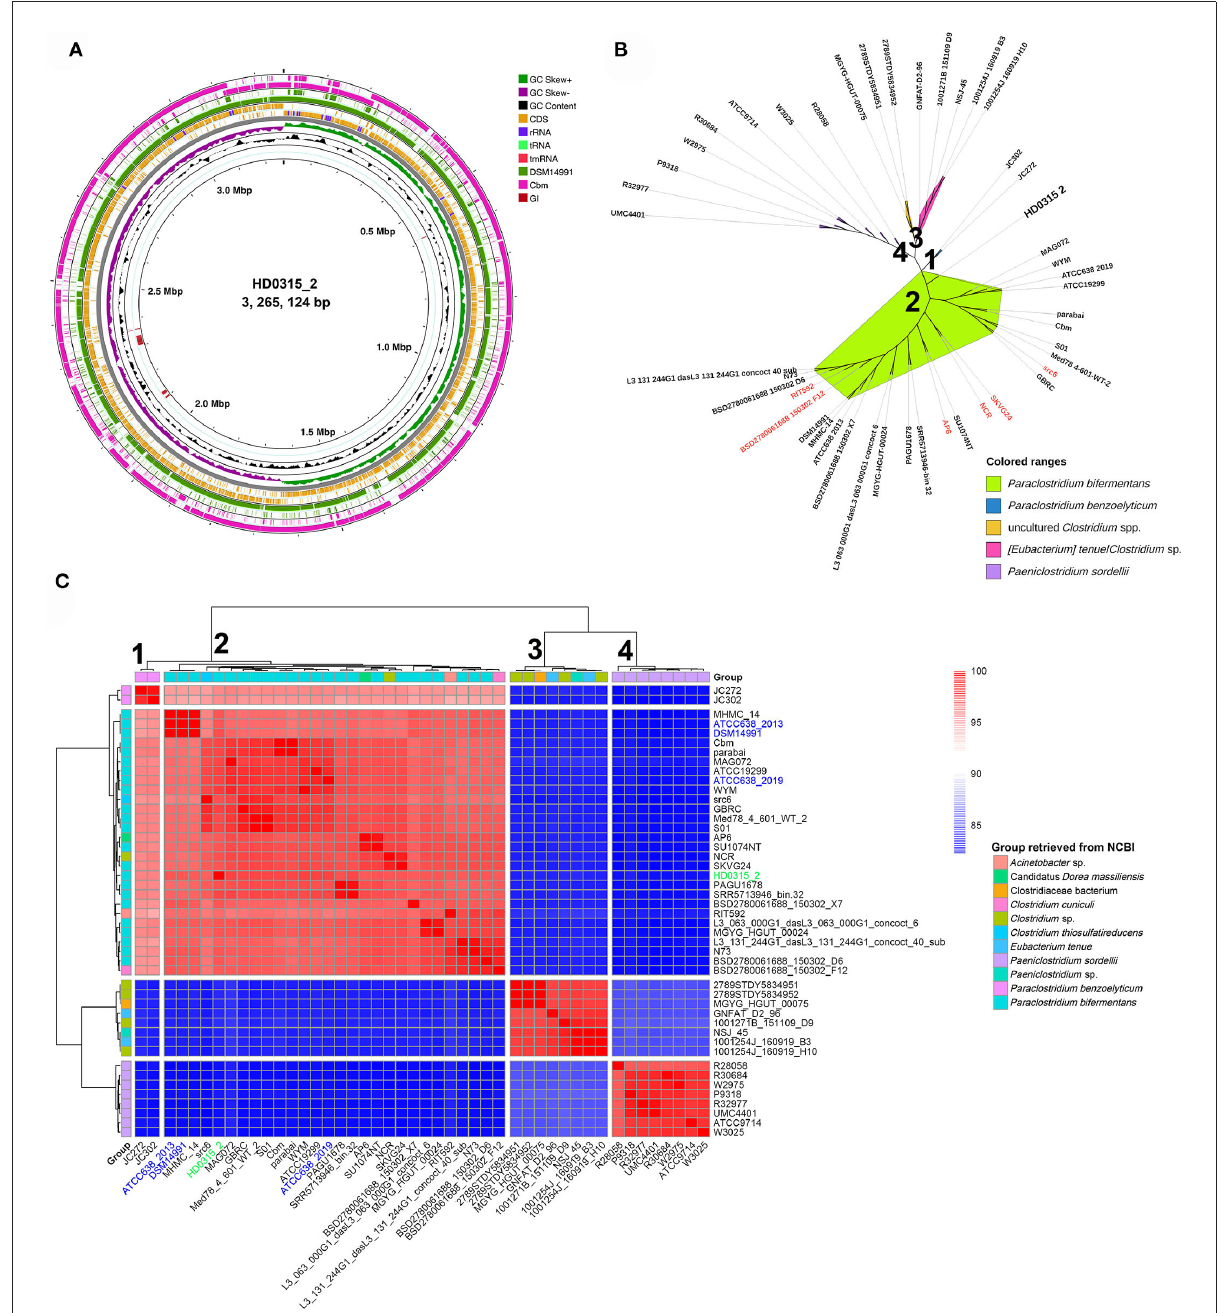
FIGURE1 The circular display of the complete genome sequence feature and phylogenomic tree originated from P. bifermentans HD0315_2. (A) From outer to inner rings: genome sequence of P. bifermentans Cbm, the genome sequence of P. bifermentans DSM14991, CDSs on the forward/reverse strand, GC skew, GC content, and genome islands. RNAs and repeat sequence regions are displayed in the CDSs circles. GI represents genome islands. (B) Phylogenomic tree constructed from WGS of the phylogenetic close strains. Numbers marked on the tree branch represent four Clades divided by phylogenomic analyses. Leaf labels with red color are those reclassified as P. bifermentans members in this study. Previously documented taxonomic information of them are listed in Supplementary Table S1. (C) Heatmap displaying the ANI between the phylogenetically close Paraclostridium spp. The color bar on the right indicates the ANI value calculated using fastANI. Numbers marked alongside the dendrogram branch represent four Clades divided by clustering. Strains names marked with blue color are type strains of P. bifermentans those with different genome versions or from different institution collections (e.g., ATCC or DSM). Strain HD0315_2 is marked with green